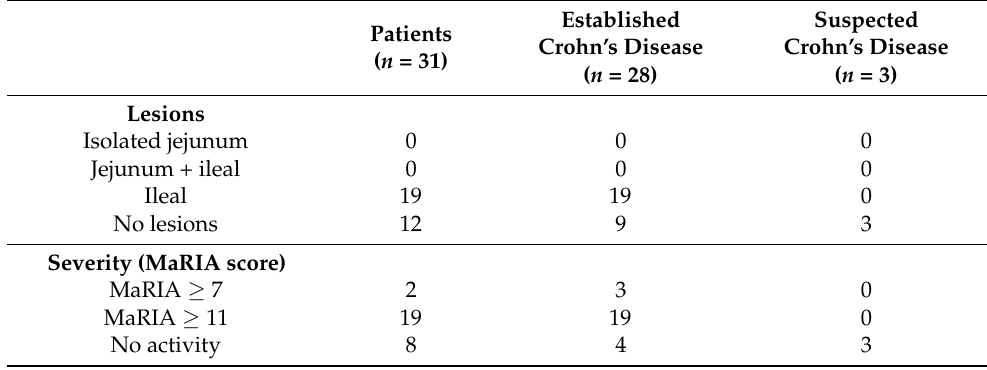
Table 6. Magnetic Resonance Enterography findings and MaRIA Score.